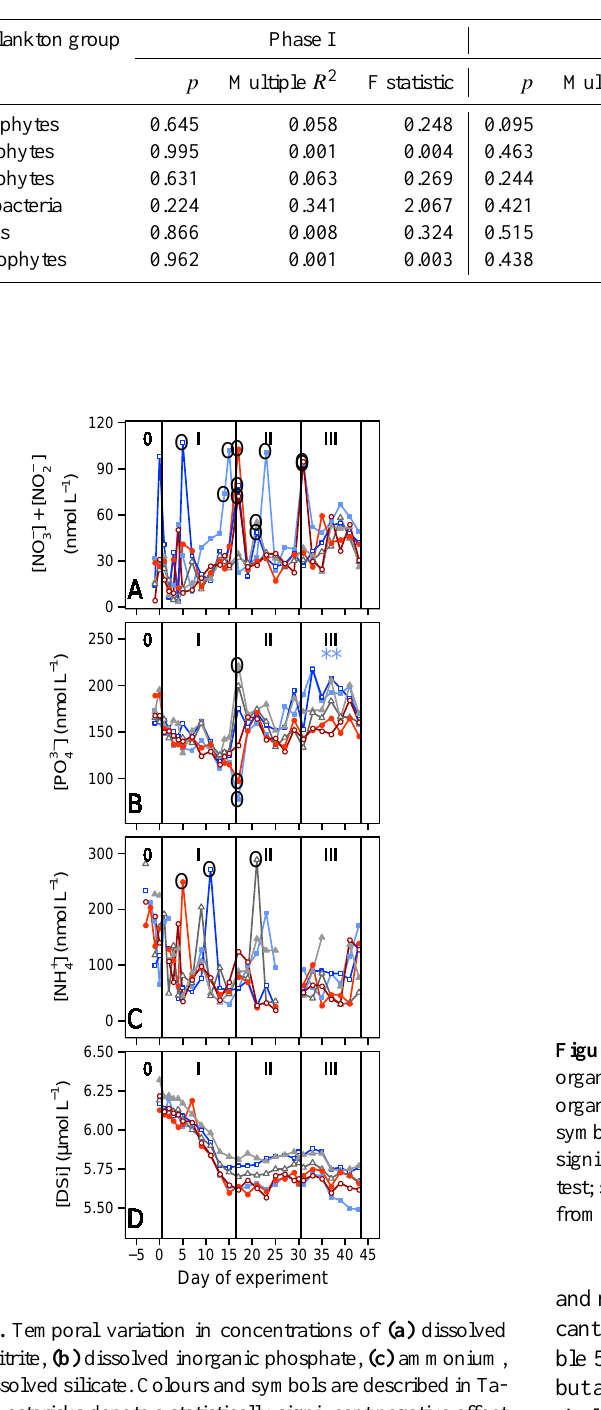
Table 4. Results of linear regression analyses of CO 2 and percentage contribution of phytoplankton groups to chlorophyll a . Bold indicates a significant positive effect, and italic indicates a significant negative effect of CO 2 .